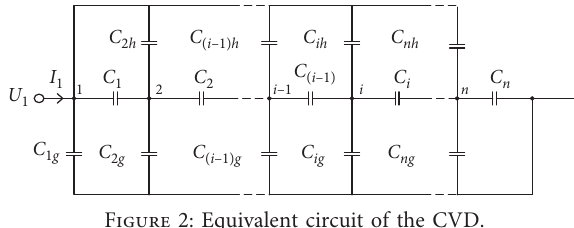
Figure 2: Equivalent circuit of the CVD.